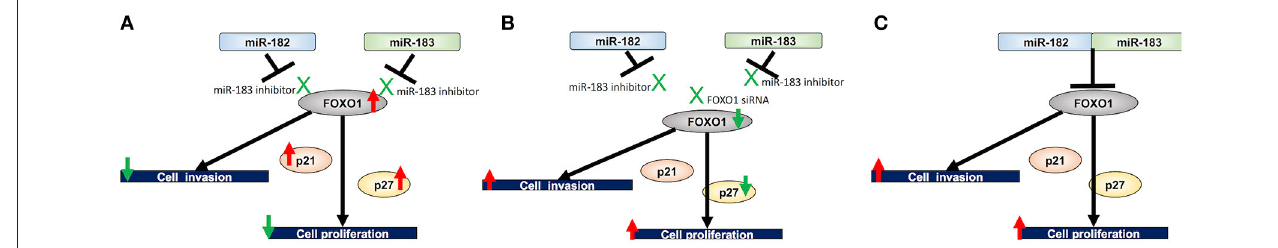
FIGURE 5 | Proposed miRNA-182/183 FOXO1 p21/27 signaling pathway. (A) Inhibition of miR-182 and miR-183 upregulates the expression of FOXO1, which in turn inhibits cell proliferation probably by acting on its downstream targets, namely, p21 and p27, and invasive ability of mesothelioma cells. (B) Treatment with FOXO1 siRNA counteracts the inhibitory effects of miR-182 and miR-183. (C) Proposed mechanisms underlying the effects of miR-182 and miR-183 on cell proliferation and invasion assay through